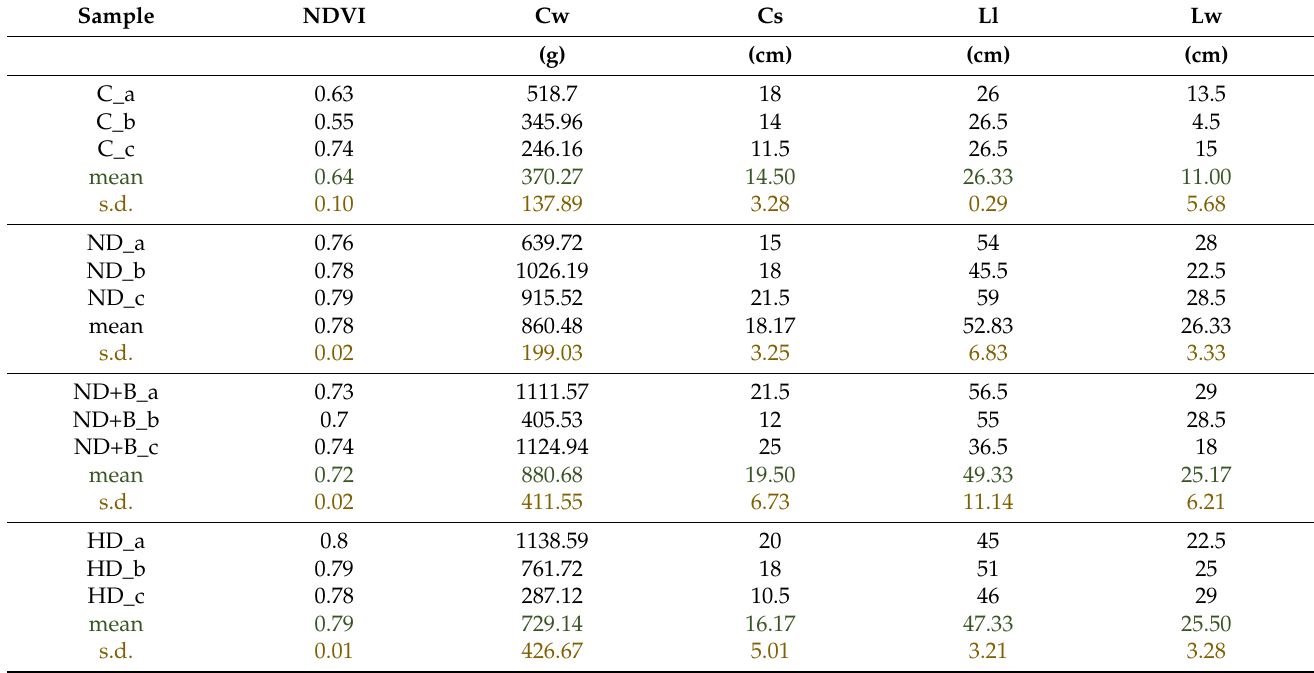
Figure 4. Results of ammonium N-leaching ( a ) and nitrate N-leaching ( b ) performance for different times and treatments. C—control; ND—normal dose; ND+B—normal dose with biochar; HD—high dose; HD+B—high dose with biochar. T1 indicates 10 days after the first treatment with nitrogenous fertilizers; T2 indicates 10 days after the second treatment. The bars represent the standard deviation. Table 3. Effect of biochar application on vegetative measurements at the end of the cauliflower growing season. The last row includes ANOVA results: * = the difference is significant at p < 0.05; ** = the difference is significant at p <